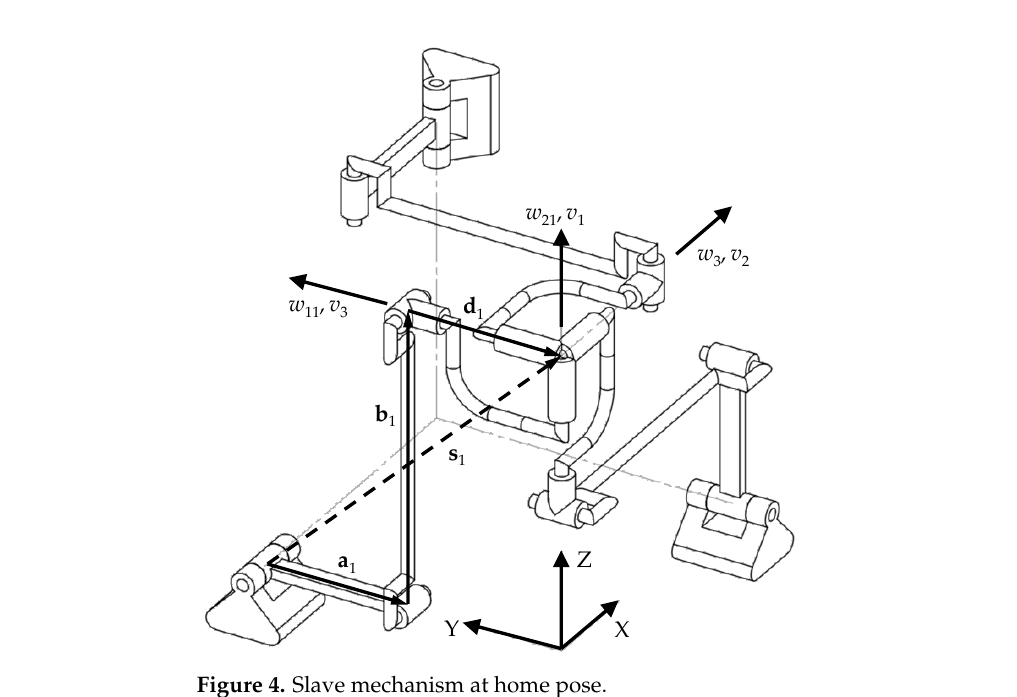
Figure 4. Slave mechanism at home